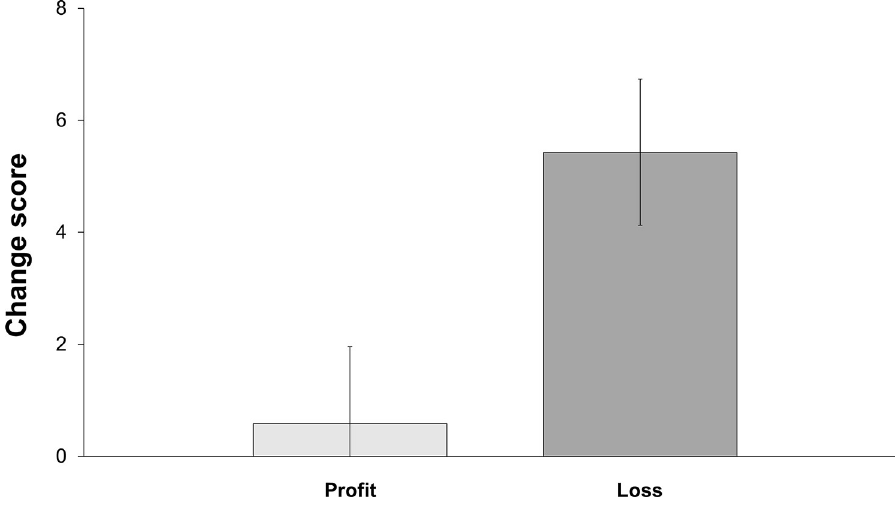
Fig 3. Change score by outcome. Note: The change score is the difference between reconsidered and initial immorality scores. The light gray bar depicts the profit case and the dark gray bar depicts the loss case.